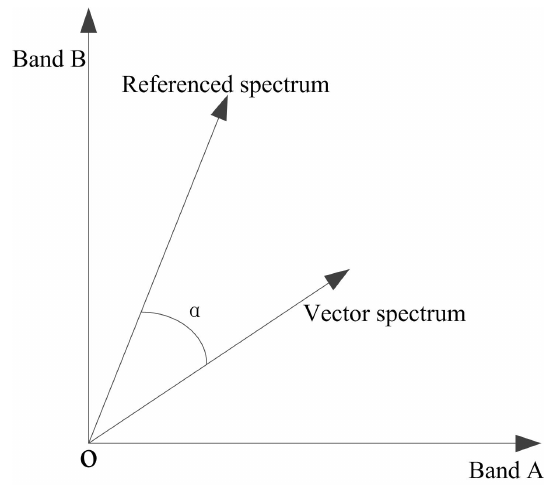
Figure 1. The diagram of Spectral Angle Mapper